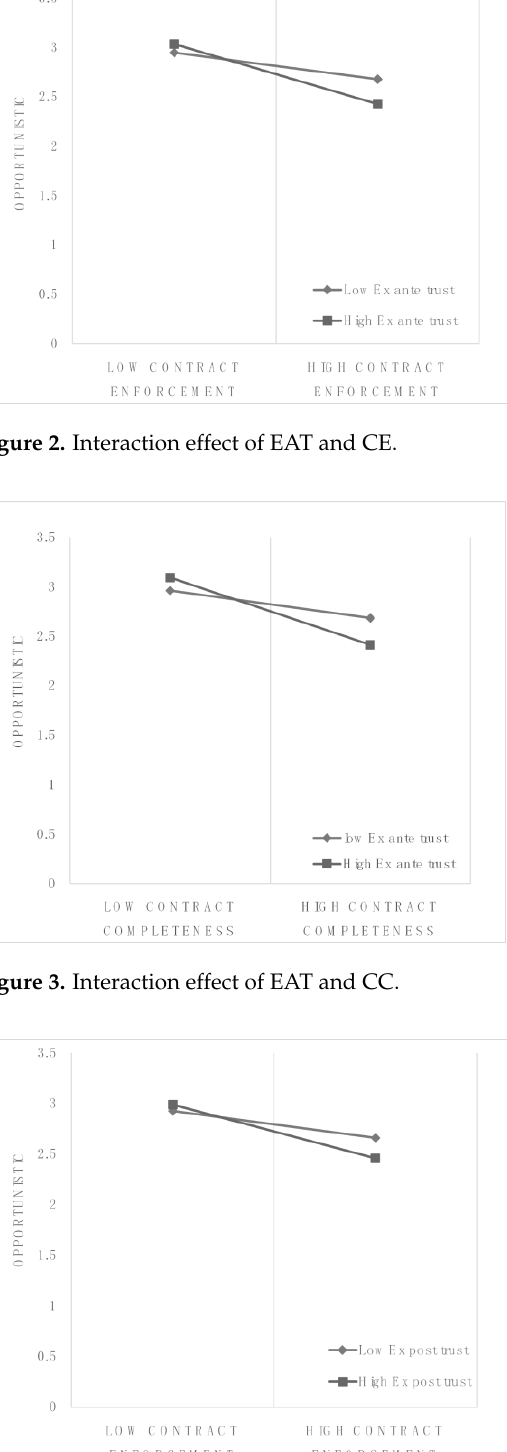
Figure 5. Interaction effect of CC and EPT. Note: source own elaboration. 6. Discussion 6.1. Theoretical Contributions Our research findings contribute to the theoretical literature in three main ways. First, our study findings confirm the effects of dynamic contract governance and trust on OB. We leveraged the GHM model of Grossman and Hart [12] in our study of project governance; according to the GHM model, contract governance is divided into contract